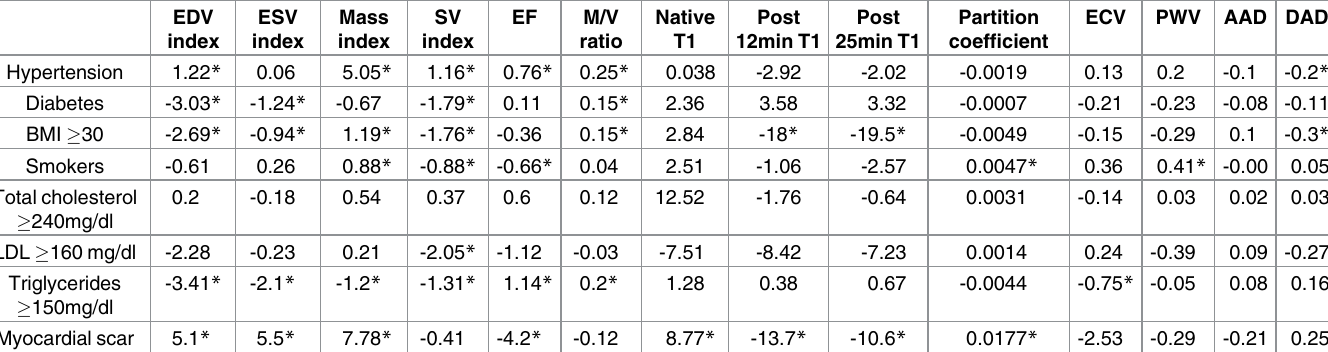
Table 5. Multivariate analysis (adjusted for age, gender, race, and all of the risk factors in the table) of associations of left ventricular (LV) struc- ture/function and aortic function versus risk factors (beta and * for p <